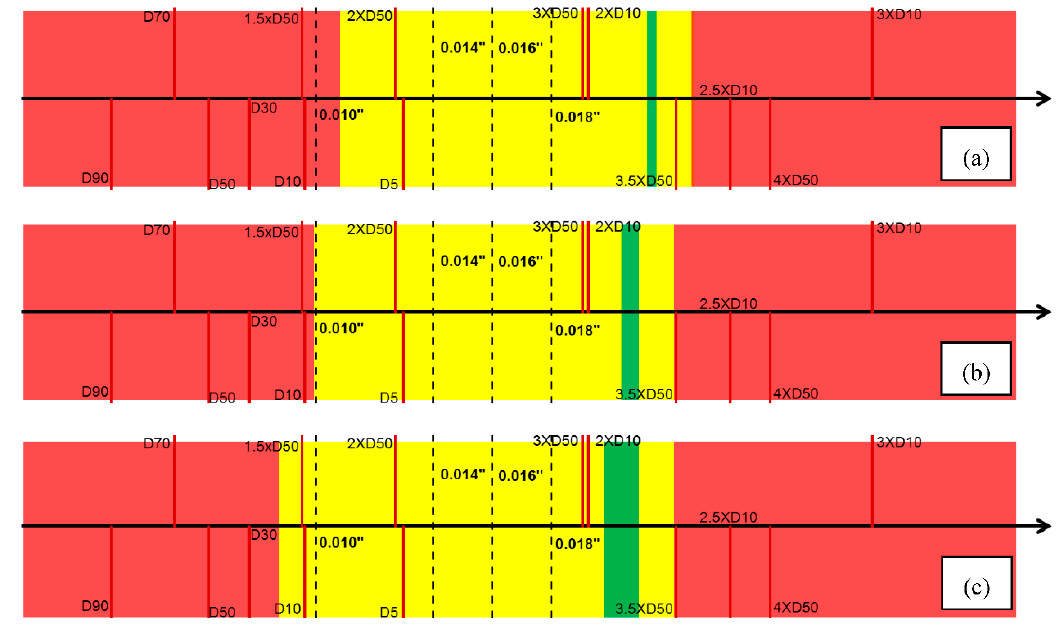
Figure 12. TLS of DC ‐ I in the aggressive condition for SPF 120 ( a ), SPF 168 ( b ), and SPF 216 ( c ).